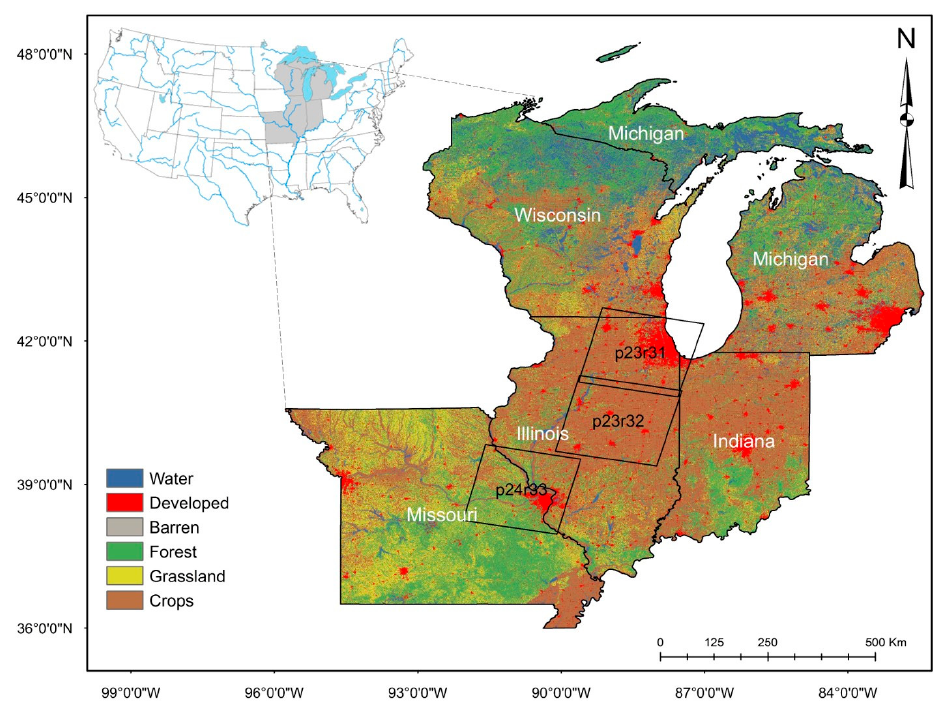
Figure 1. Midwestern US study area encompasses over 100,000 km 2 , including urbanizing Chicago, Illinois (p23r31) and St. Louis, Missouri (p24r33) regions, as well as rural areas of central Illinois (including Peoria, the developed area in the northwestern corner of p23r32). The background land use/land cover (LULC) data are from the 2001 national land cover dataset (NLCD) [41], binned into gross LULC classes, as described in Section 2.3.2, below.